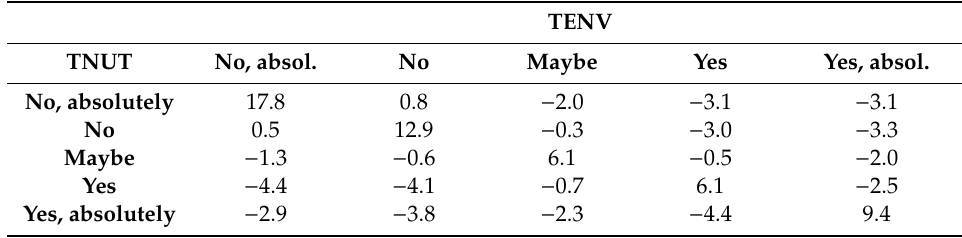
Table 4. Pearson’s standardized residuals from a two-way table of superior nutrition properties (TNUT) and lower environmental impact Figure 2. Willingness to try food containing upcycled ingredients with superior nutrition properties (TNUT) or lower environmental impact (TENV).